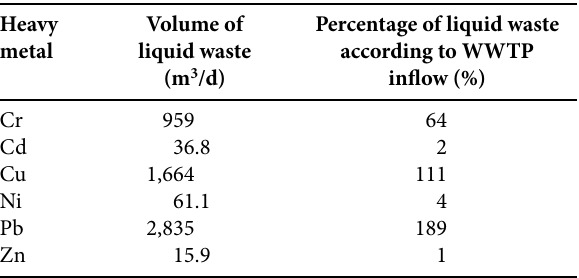
Table 5. The percentage of industrial wastewater to the WWTP (with a capacity of 10,000 inhabitants) for selected heavy metals.